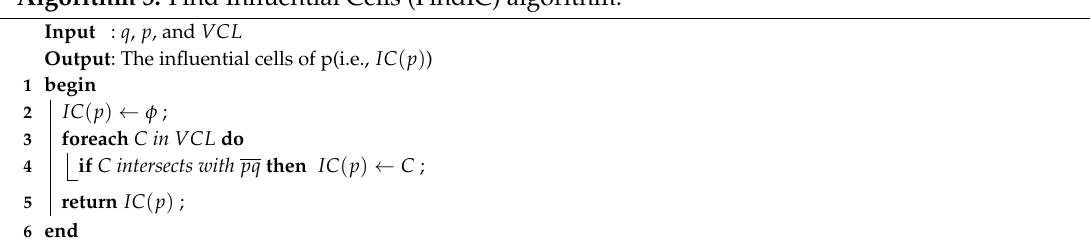
Algorithm 5. Find Influential Cells (FindIC)